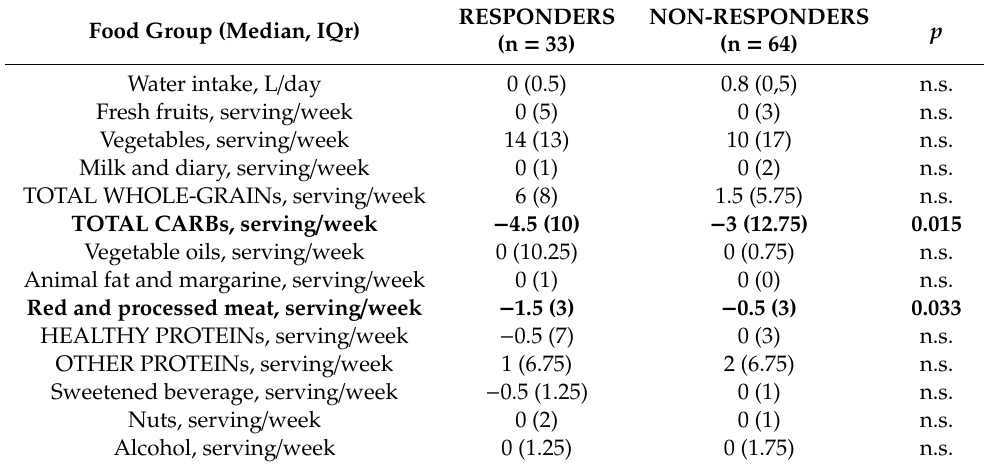
Table 4. Changes in food group weekly intake in RESPONDERS compared with NON- RESPONDERS.